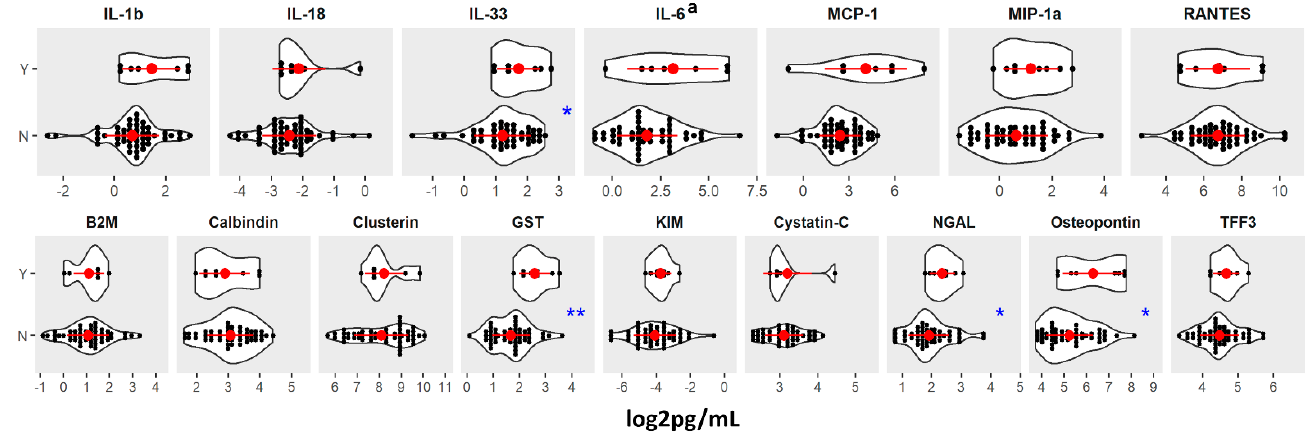
Figure 2. Cytokine and Renal toxicity marker levels by COVID-19 in-hospital death (Y vs N). *: adjusted p -value (FDR) ≤ 0.1; **: adjusted p -value (FDR) ≤ 0.05. a: patients on cytokine inhibitor were excluded for analysis.